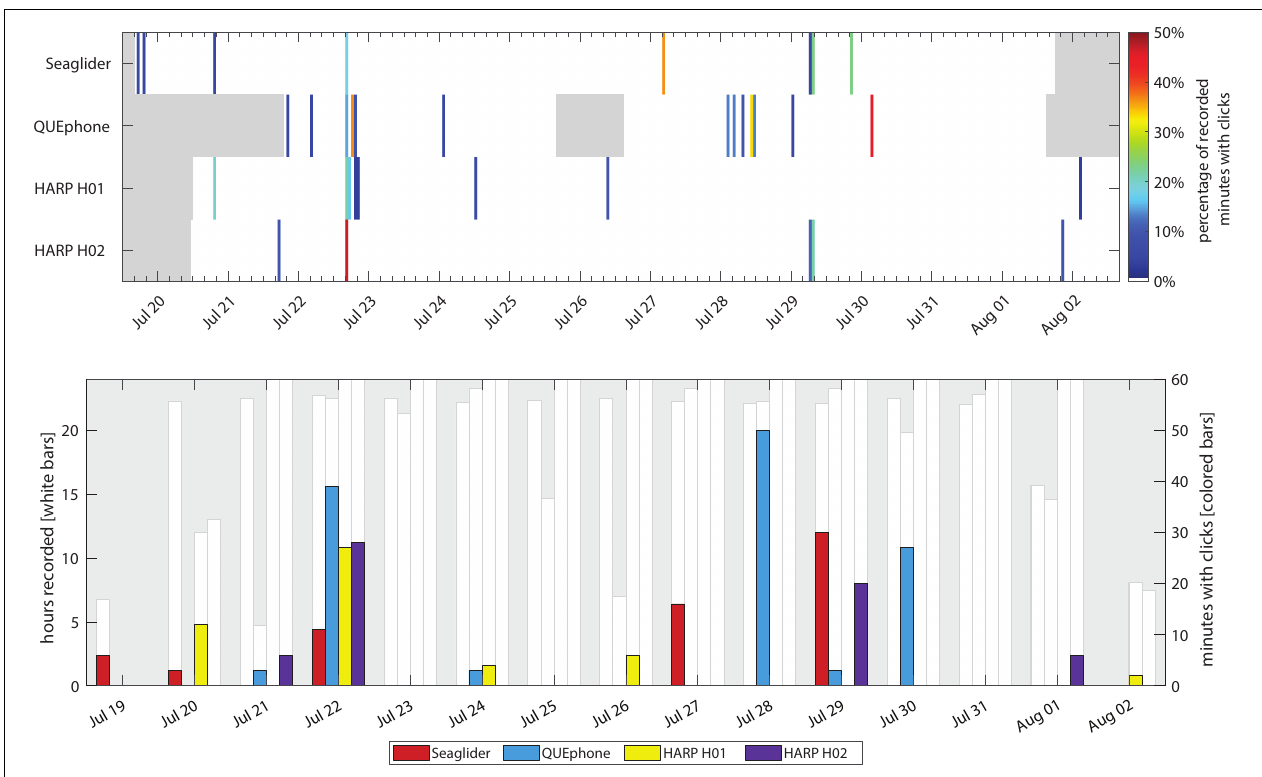
FIGURE 2 | Occurrence of Cuvier’s beaked whale clicks by recorder platform. Top panel: Percentage of recorded minutes with clicks in each hour. Gray areas indicate times when recorders were not deployed. Color of each 1-h bar corresponds to percentage of total minutes recorded in that hour with clicks (if 0%, no colored bar is displayed). Bottom panel: Minutes with Cuvier’s beaked whale clicks per day. The white bars and left y -axis indicate the total hours recorded per day. No white bar indicates a day where that recorder was either not deployed or not yet recording. The right y -axis and colored bars indicate total minutes per day containing beaked whale